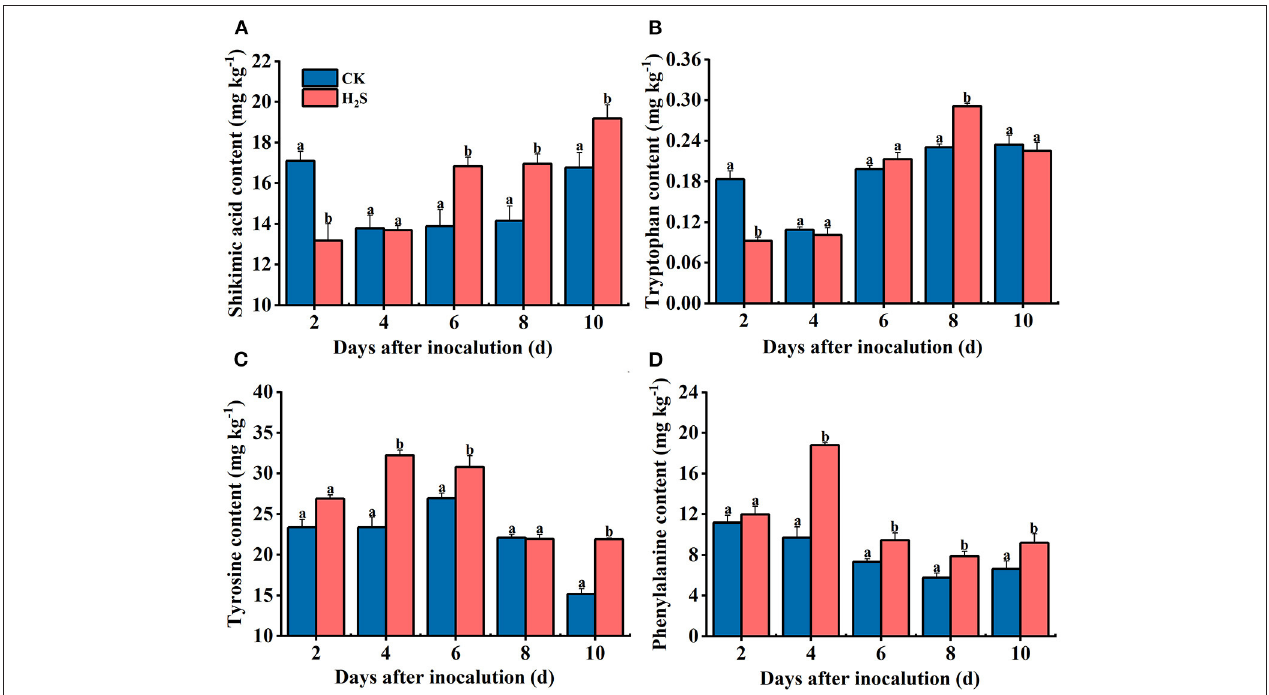
FIGURE 5 | Shikimic acid (A) , tyrosine (B) , tryptophan (C) , and phenylalanine (D) contents in kiwifruit with inoculation of B. dothidea after the H 2 S treatment during storage at 25 ◦ C. Vertical bars represent the standard errors. Letters indicate significant differences ( P <